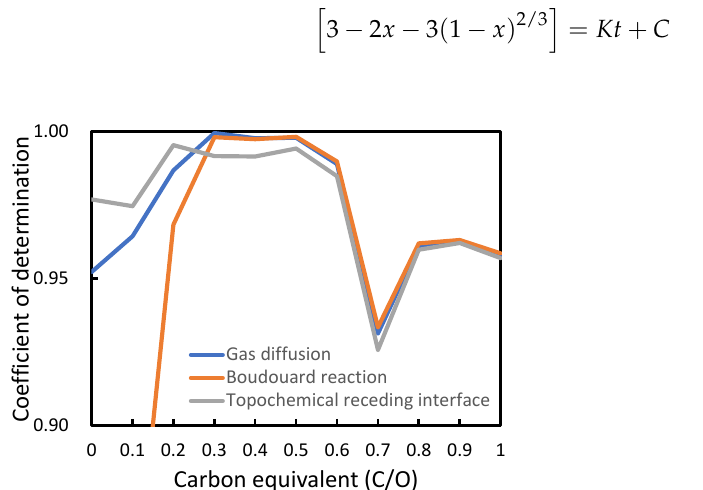
Figure 9. Comparison of the validity of various kinetic models in analyzing reduction process.